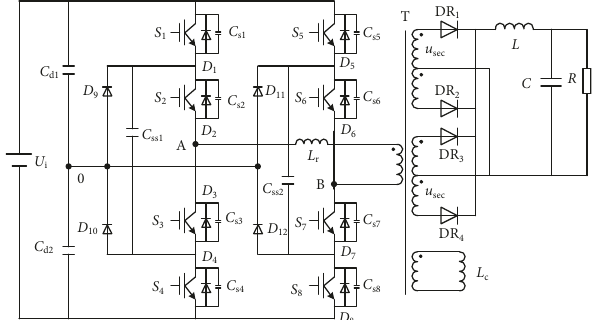
Figure 6: The improved three-level controlled-source circuit. (4) Parameters of two rectifying-circuit devices at the